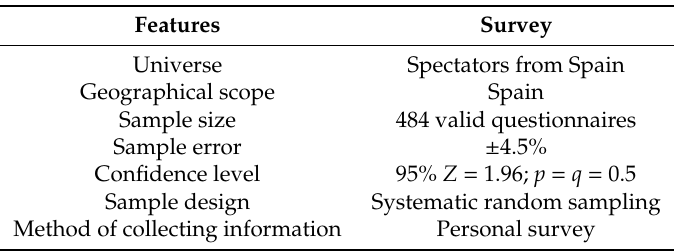
Table 2. Technical data of the study.